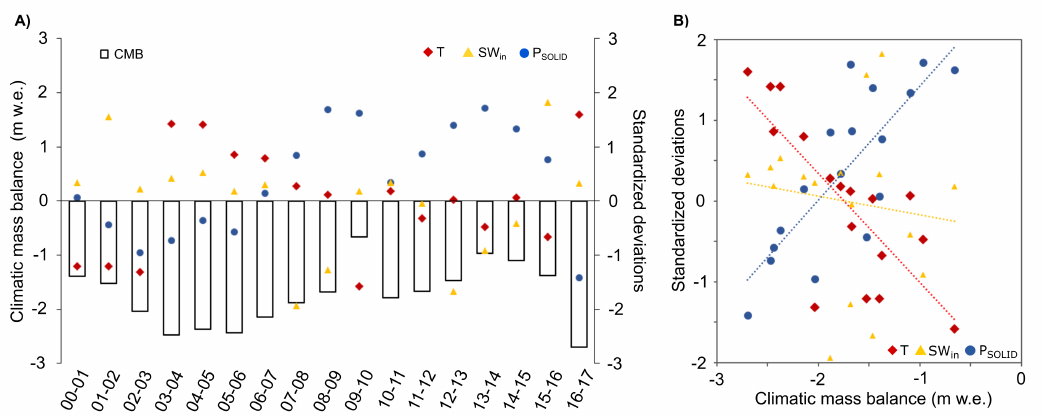
Figure 7. Modeled annual climatic mass balance (CMB) based on COSIPY simulations and standardized anomalies of P solid , T 2 m , and SW in from the mean between April 2000 to March 2017 for each mass balance year ( A ) and correlations between modeled annual CMB and standardized anomalies of P solid , T 2 m , and SW in from the mean between April 2000 to March 2017 ( B